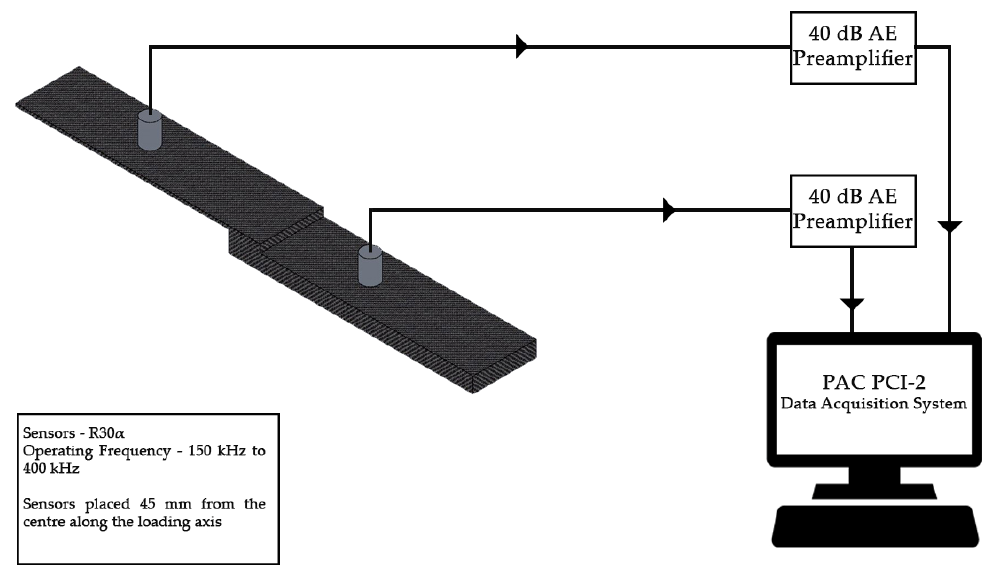
Figure 3. Schematic of Acoustic Emission Setup.